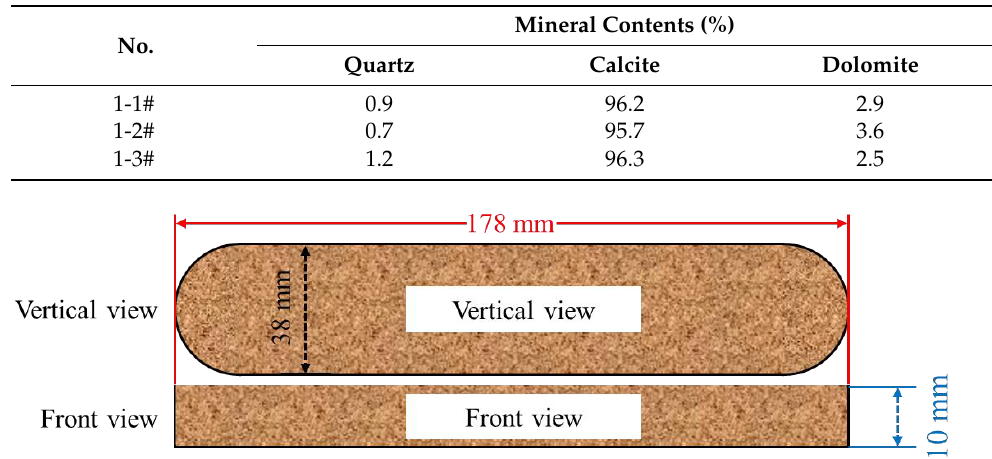
Table 2. Porosity and permeability analysis results. Table 1. XRD mineral analysis results.